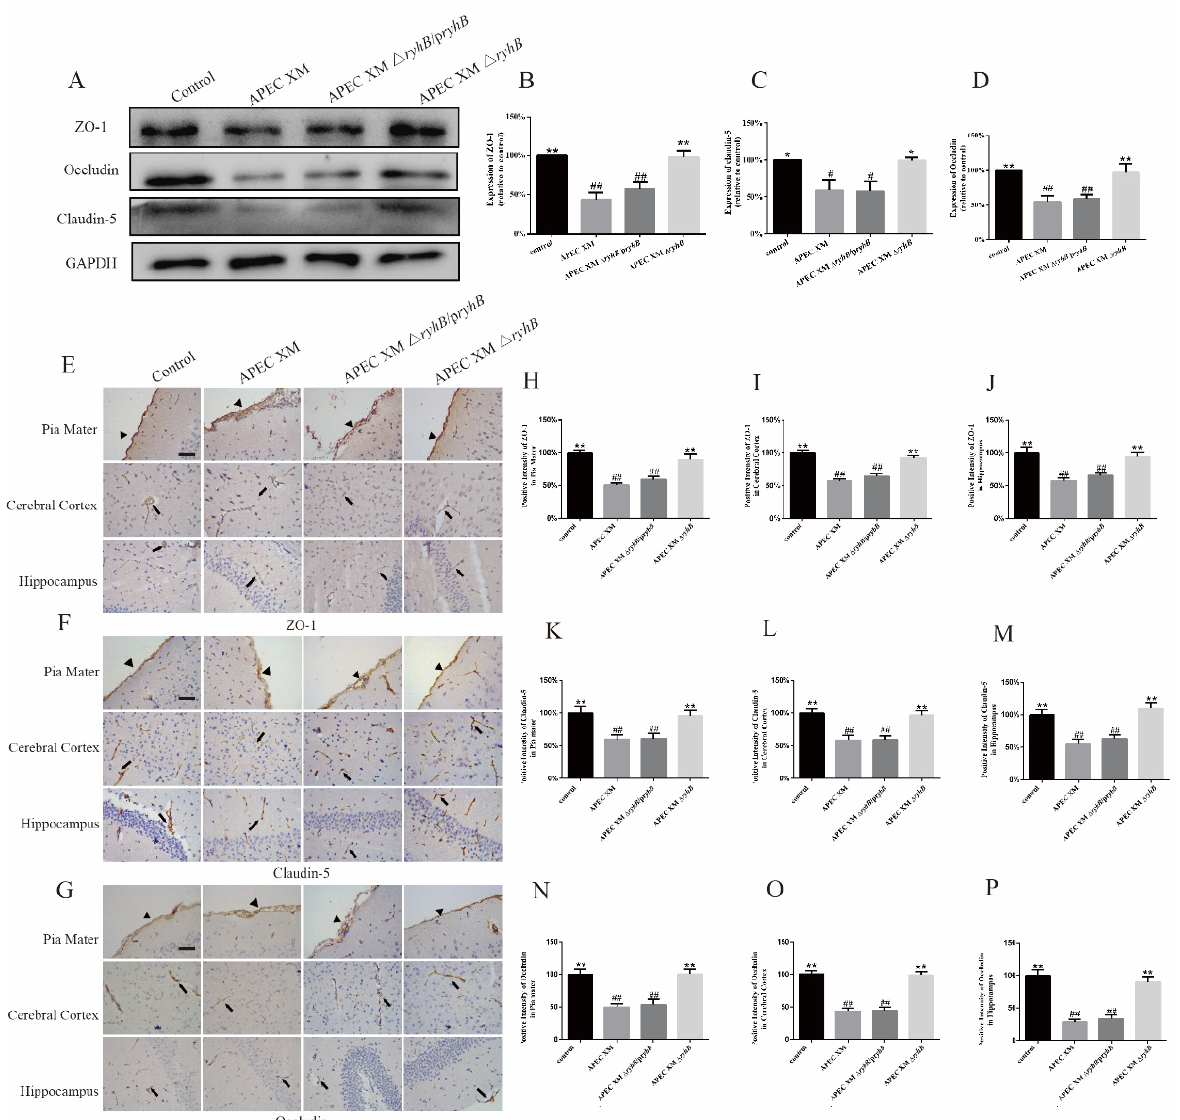
Figure 12. The expressions of ZO-1, claudin-5 and occludin in the brain tissues were measured using Western blot and immunohistochemistry. ( A – D ) The expressions of ZO-1 ( A , B ), claudin-5 ( A , C ) and occludin ( A , D ) in the brain were measured using Western blot . GAPDH was used as a loading control. The protein expression in control group is defined as 100%. ( E – P ) The expressions of ZO-1, claudin-5 and occludin in the brain were measured using immunohistochemistry. The representative immunohistochemistry staining of ZO-1 ( E ), claudin-5 ( F ) and occludin( G ) proteins were displayed in the brain sections of infected mice (bar = 20 µm). The black arrowheads point to pia maters and the black arrows point to microvascular. The percentage of positive staining inten- sity of ZO-1 ( H – J ), claudin-5 ( K – M ) and occludin ( N – P ) in pia mater, cerebral and hippocampus were calculated by defining the relative optical density of the control group as 100%, and the rela- tive optical densities of other groups are normalized by the control group. These results are pre- sented as the means ± standard error of the mean for three independent experiments. (**, p < 0.01, *, 0.01 < p < 0.05, versus APEC XM group; ##, p < 0.01, #, 0.01 < p < 0.05 versus control group). 3. Discussion E. coli meningitis is an important cause of mortality and morbidity worldwide and usually leads to neurological sequelae in survivors [35]. Cases of meningitis are increas-